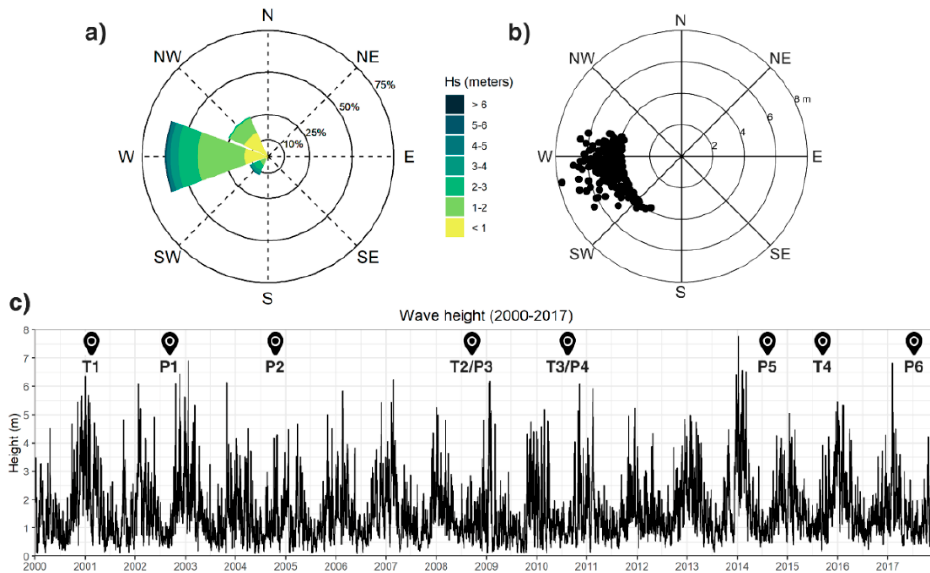
Figure 2. Wave data about SIMAR point 3010013 between January 2000 and December 2017. ( a ) Wave rose with direction and height in percentage; ( b ) Direction and height of storm days defined as days with mean Hs > 0.95, in this period the Hs 0.95 = 3.78 m; ( c ) Timeseries with mean daily Hs. Marks indicate the aerial images and orthophotographs date acquisition (starts with letter P and the entire code appear in Table 1) and the moment of topographic or LiDAR (Light Detection and Ranging) surveys (starts with letter T and the entire code appear in Table 2). Data from: Meteogalicia [38] and IGN (Instituto Geográfico Nacional) [37].